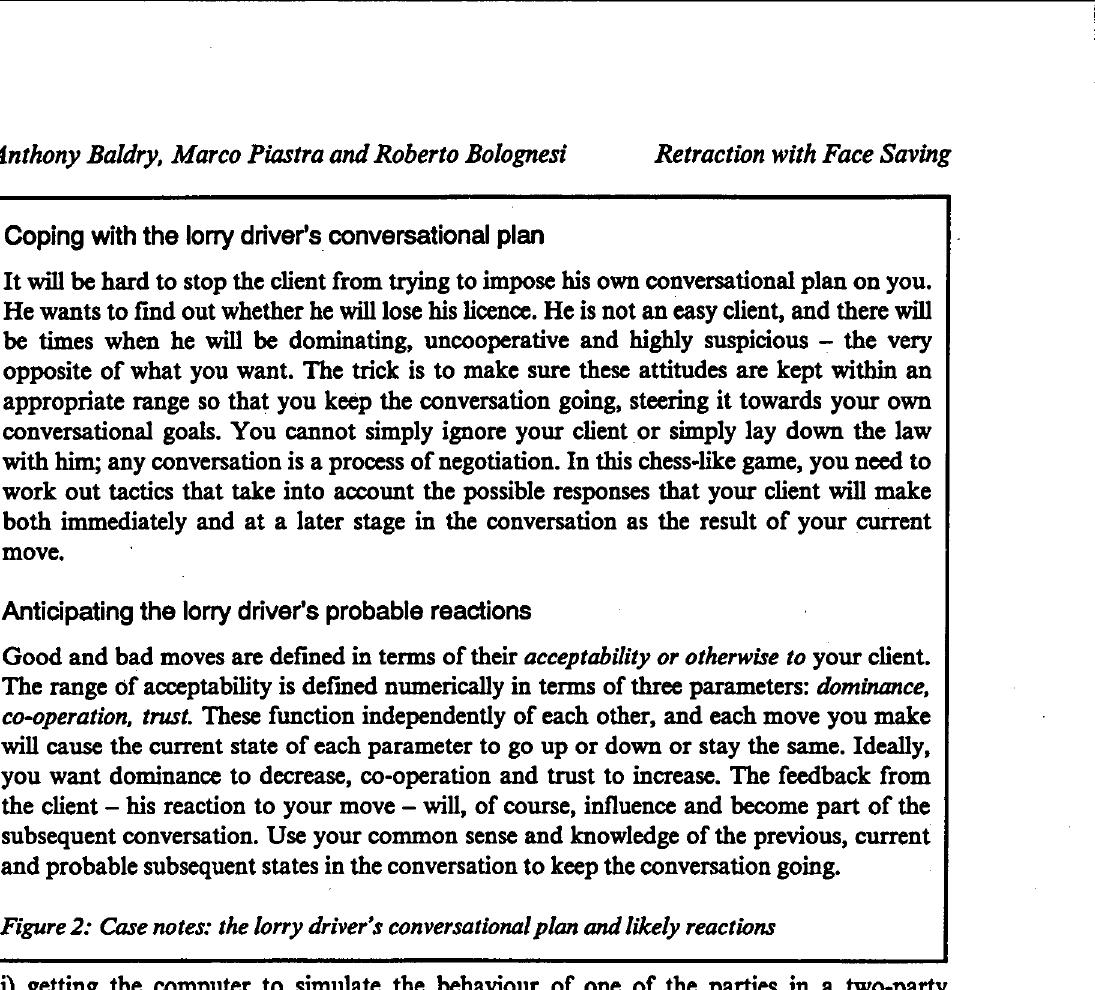
Figure 2: Case notes: the lorry driver's conversational plan and likely